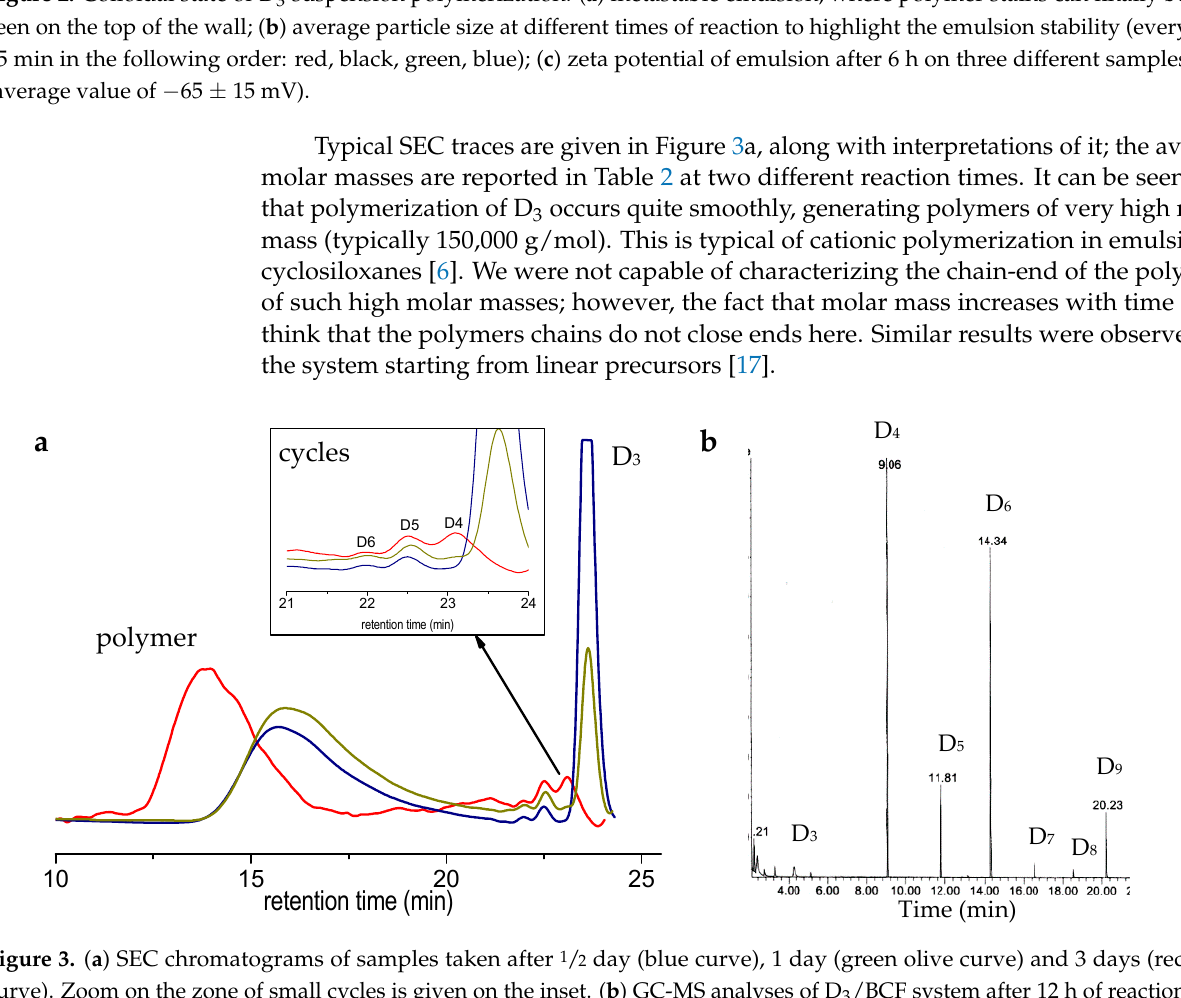
Figure 3. ( a ) SEC chromatograms of samples taken after ½ day (blue curve), 1 day (green olive curve) and 3 days (red curve). Zoom on the zone of small cycles is given on the inset. ( b ) GC-MS analyses of D 3 /BCF system after 12 h of reaction. Abundances are relative, since peaks appear larger as molar mass of the cycle increases.